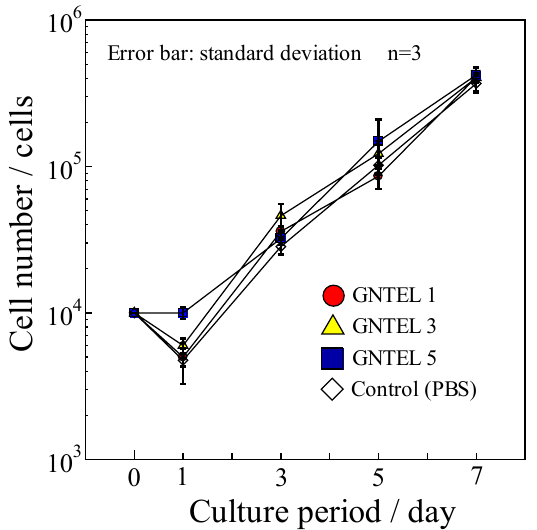
Figure 6. Cell proliferation curve of MG-63 using cell culture medium with GNTELs.